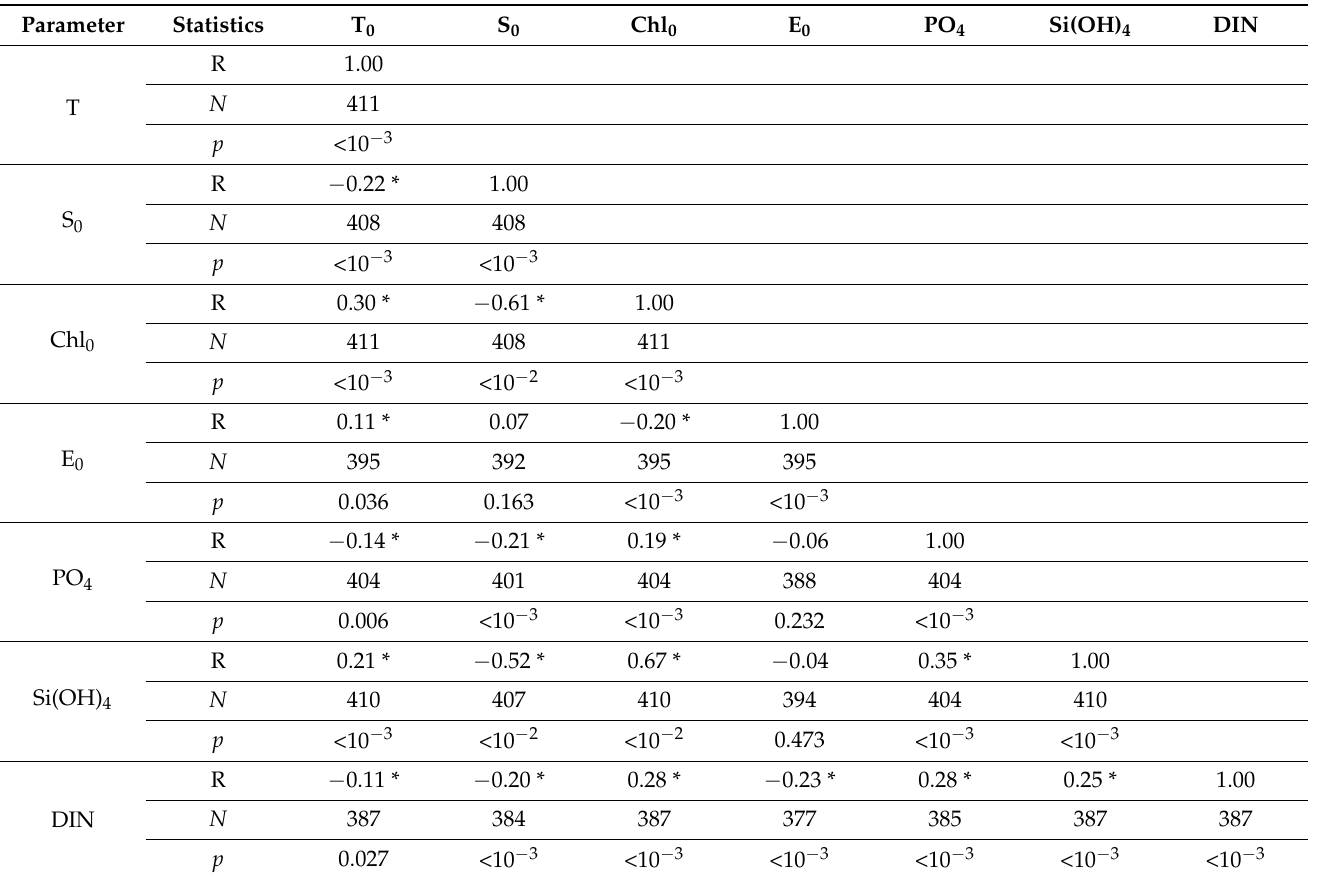
Table 5. The correlation matrix between the log-transformed values of environmental vari- ables. R—coefficient of correlation; p value—statistical significance of R; N —the number of data. T 0 —surface water temperature; S 0 —surface salinity; PO 4 , Si(OH) 4 and DIN—surface concentra- tions of phosphates, dissolved silicon, and dissolved inorganic nitrogen, respectively; Chl 0 —surface chlorophyll a concentration; E 0 —subsurface PAR. The asterisks indicate significant correlations ( p <